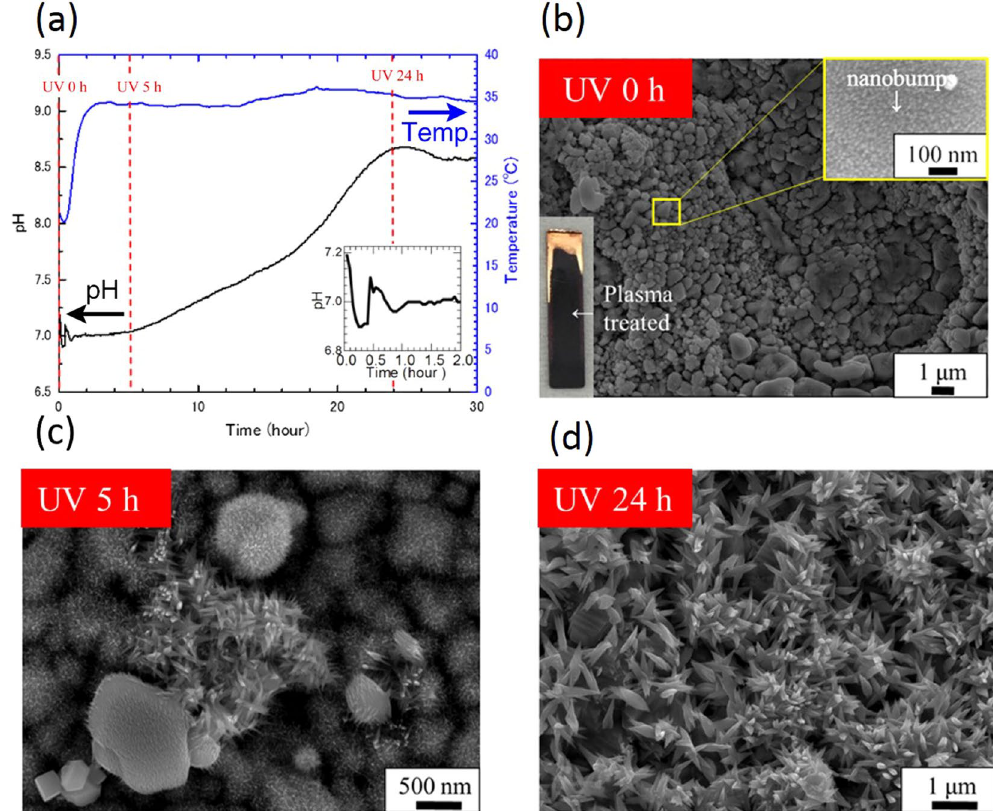
Figure 2. Photochemical reaction tracking on CuO formation. A pH-temperature graph during SPSC in ( a ) with respective UV irradiation times indicated by the red lines. Inset is the magnified time dependence pH during initial 2 hours UV irradiation. ( b ) FE-SEM image of the sample before UV irradiation. Inset is the enlarged image. Fine irregularities on the order of a few nanometers on the surface (nanobumps) can be observed. ( c ) Is fine fibrous crystals seen in samples after 5 hours of UV irradiation. ( d ) Is the sample after 24 hours UV irradiation; nanoflowers were formed on the surface.